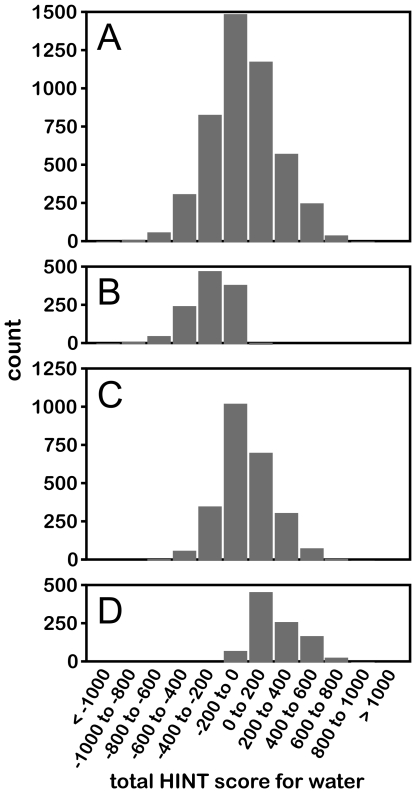
Histograms illustrating distribution of HINT scores for water molecules.(A) All waters in data set; (B) water molecules with Relevance to neither protein; (C) waters with Relevance to one protein; (D) waters with Relevance to both proteins. Note that 500 HINT score units is approximately −1.0 kcal mol−1.